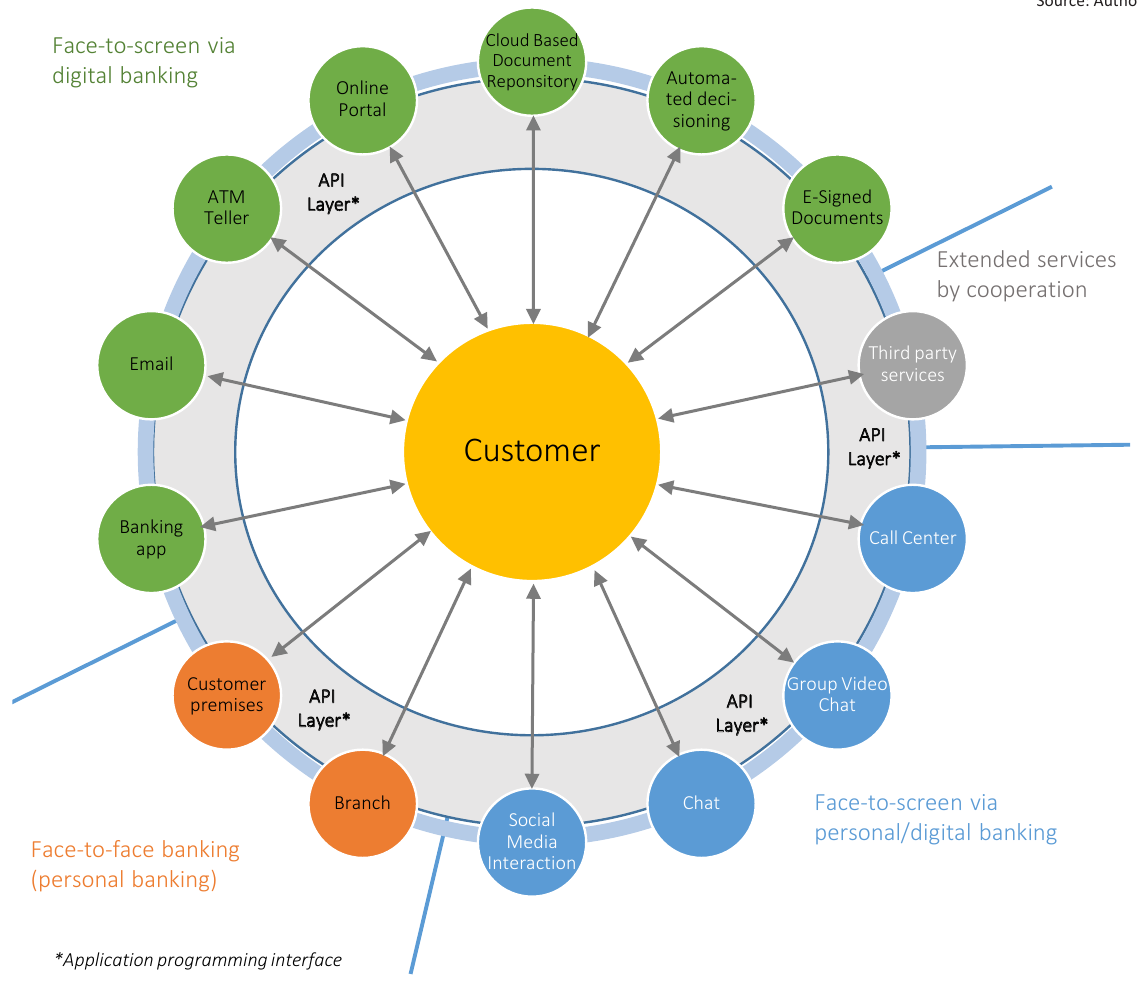
Figure 1. Data management in an omni-channel environment